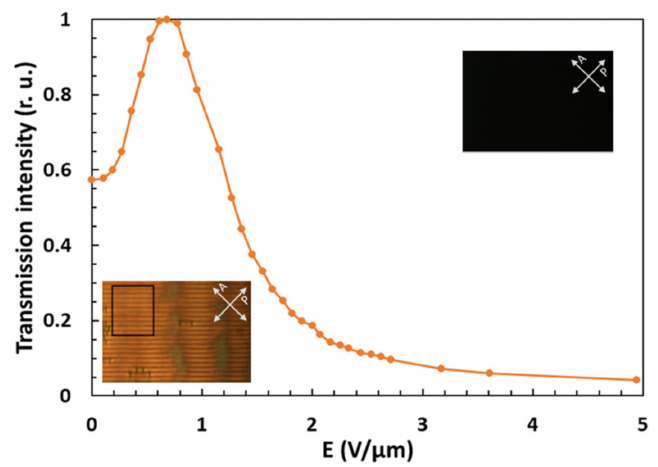
Figure 3. Normalized average transmission intensity as a function of the applied electric field E . The insets show polarization optical microscopy (POM) images of the grating structure at E = 0 V/ µ m (lower left corner) and E = 4.6 V/ µ m (upper right corner). A black rectangle denotes the region of interest (ROI) with a size of around 50 × 50 µ m 2 . Arrow-ended white lines denote orientations of the polarizer (P) and the analyzer (A).